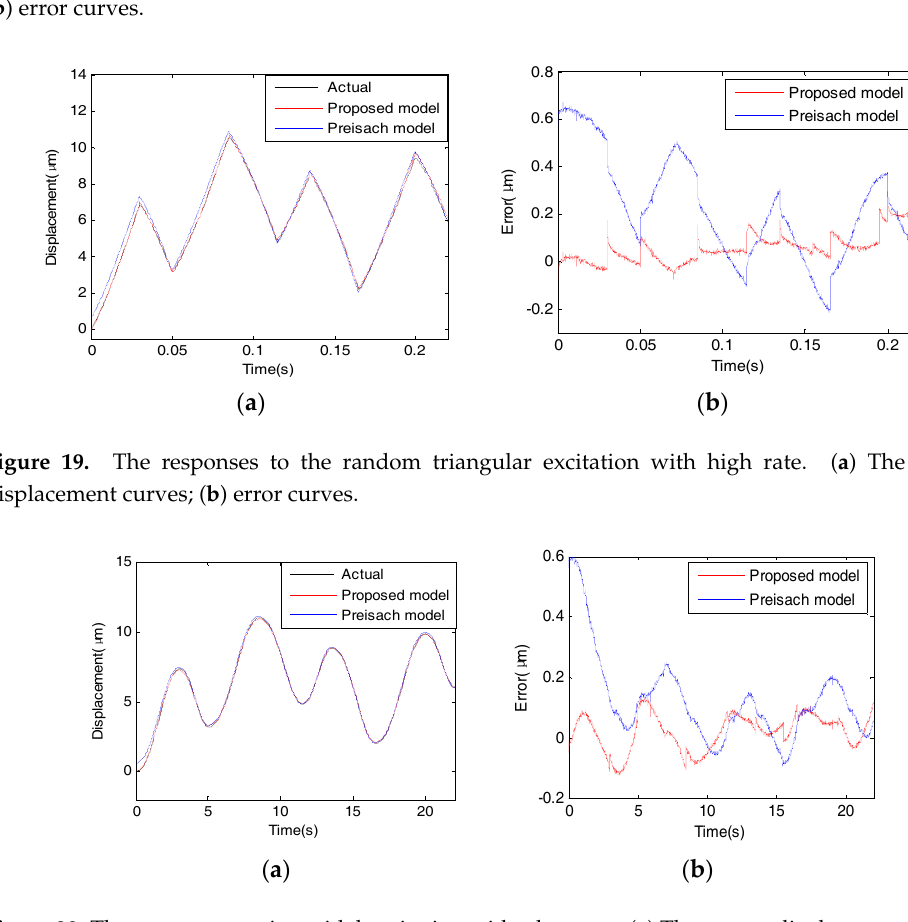
Figure 20. The responses to sinusoidal excitation with a low rate. ( a ) The output displacement curves; ( b ) error curves.